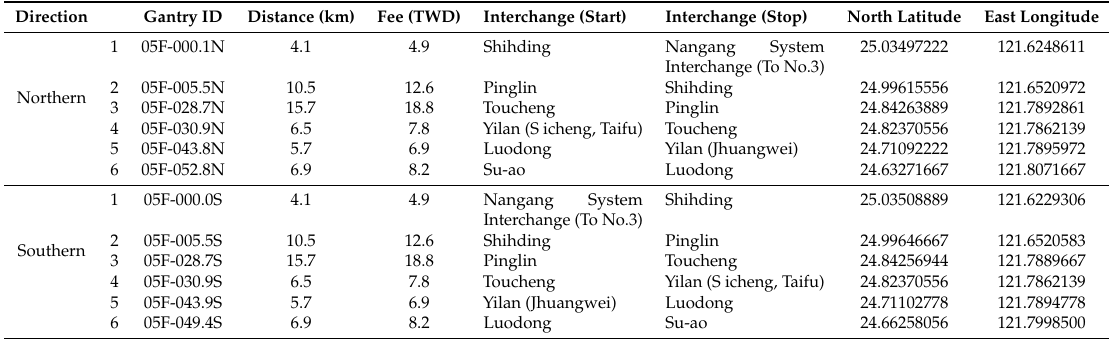
Table 3. Six gantries in both of the southern and northern directions on Taiwan National Freeway No. 5.